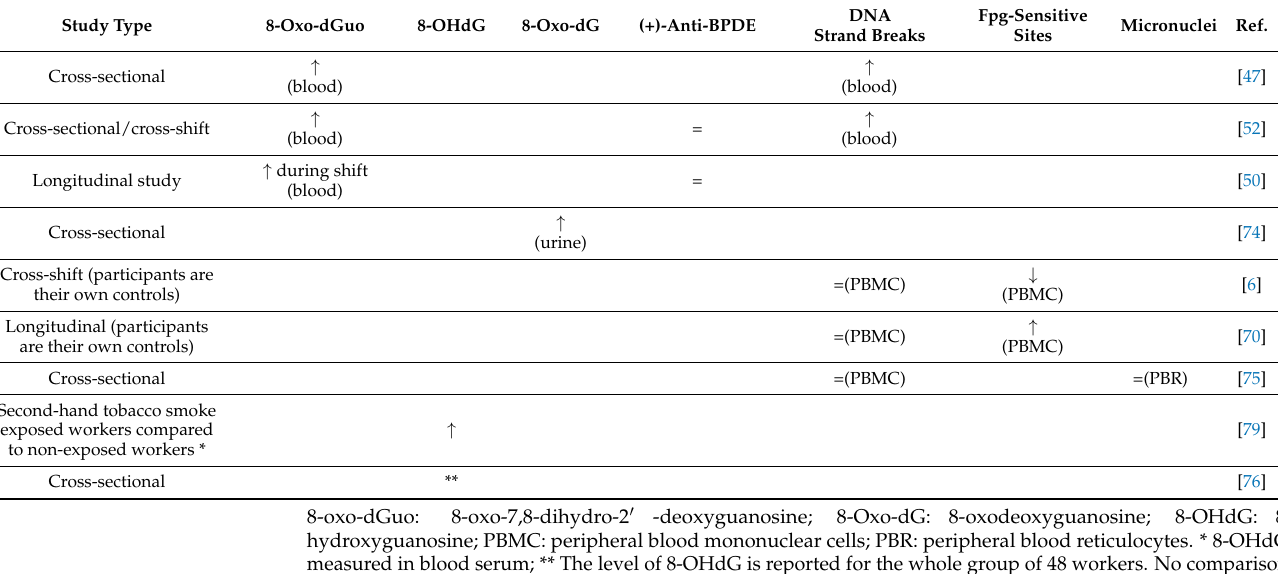
Figure 2. Urinary levels distribution of 1-OH-PYR across several industries in the literature. Creat: creatinine. Minimum and maximum values are shown together with median/mean (black square) whenever available. The y-axis is depicted in logarithmic scale.